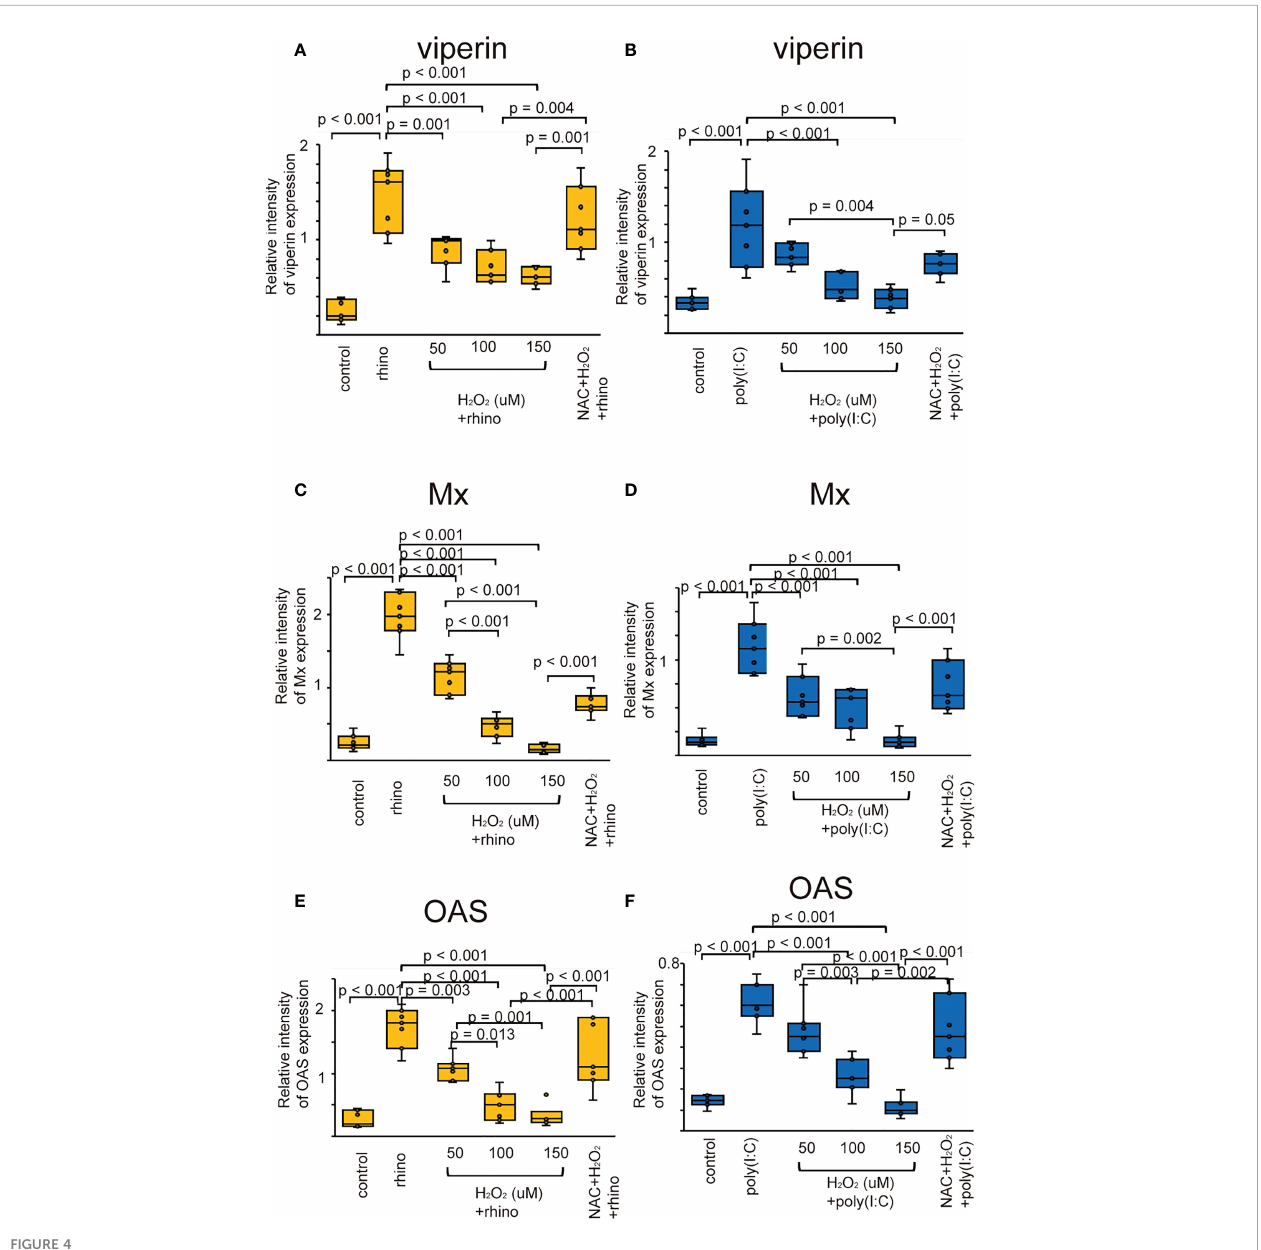
FIGURE 4 The expression level of viperin (A, B) , Mx (C, D) , and OAS (E, F) proteins in sinonasal epithelial cells pretreated with H 2 O 2 at 50, 100, and 150 uM and then, followed by RV 16 infection ( A, C, E) or poly (I: C) treatment (B, D, F) which were evaluated with western blot. Data are mean ± SEM from 7 different epithelial donors. Control indicates non-treated normal epithelial cells. Rhino indicates epithelial cells infected with RV 16. H 2 O 2 + rhino indicates the epithelial cells pretreated with H 2 O 2 at 50, 100, and 150 uM followed by RV 16 infection. NAC+ H 2 O 2 +rhino indicates the cells which were pretreated with NAC at 5 mM for 1 h and then followed by H 2 O 2 treatment at 100 uM and subsequently infected with RV 16. Poly (I: C) indicates epithelial cells treated with poly (I: C). H 2 O 2 + poly (I: C) indicates the epithelial cells pretreated with H 2 O 2 at 50, 100, and 150 uM followed by poly (I: C) treatment. NAC+ H 2 O 2 + poly (I: C) indicates the cells which was pretreated with NAC at 5 mM for 1 h and then followed by H 2 O 2 treatment at 100 uM and subsequently treated with poly (I: